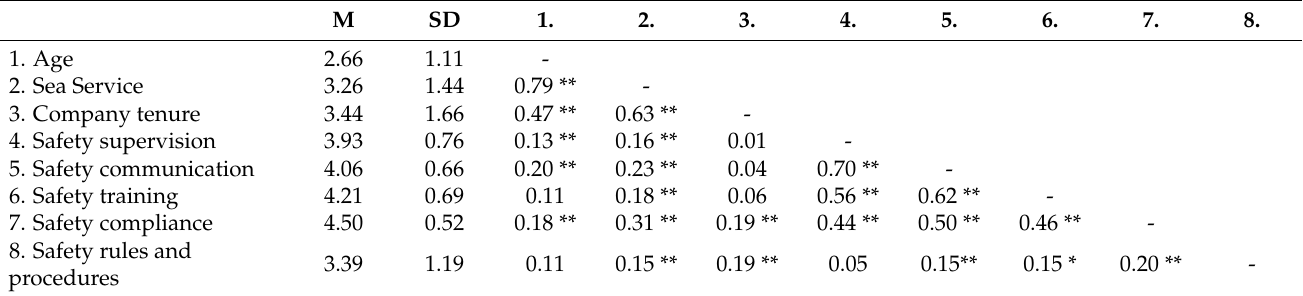
Table 3. Means, standard deviations, and correlations among study variables ( n =